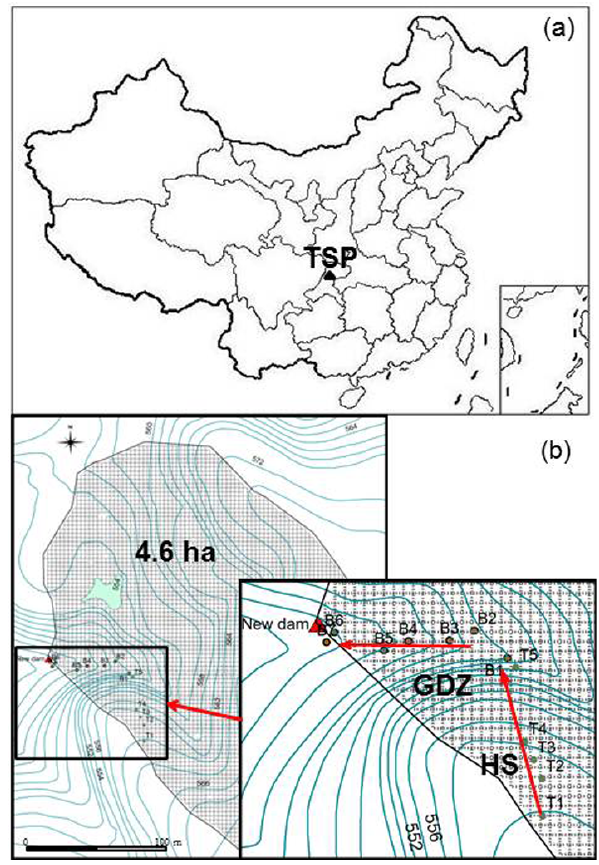
Fig. 1. (a) Location of the Tieshanping (TSP) forest catchment, Chongqing, China and (b) plot layout in the TSP catchment. Plots T1 to T5 constitute transect T on the hillslope (HS); plots B1 to B6 constitute transect B in the groundwater discharge zone (GDZ). Increasing plot numbers denote decreasing elevation along the tran- sects. Plots T5 and B1 are at the intersection of HS and